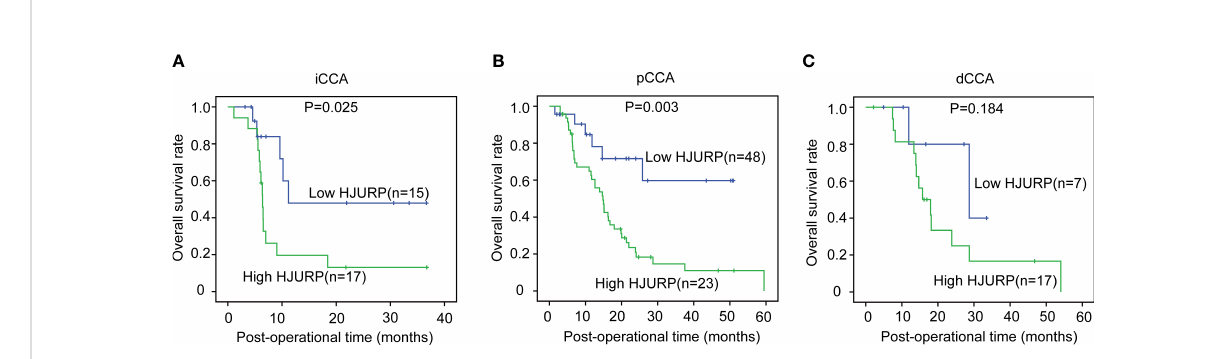
FIGURE 2 The prognostic signi fi cance of HJURP in iCCA, pCCA, and dCCA. The patients with iCCA (A) , pCCA (B) , and dCCA (C) were divided into low- or high-HJURP subgroups, and the statistical signi fi cance between subgroups was analyzed with the log-rank test.